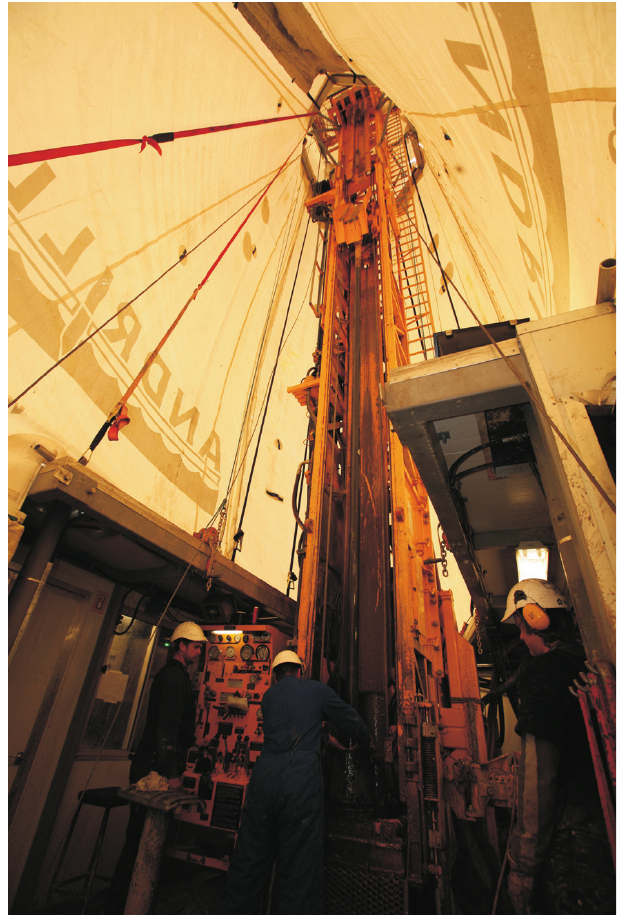
Figure 5. Drilling operations under the ANDRILL drill-rig